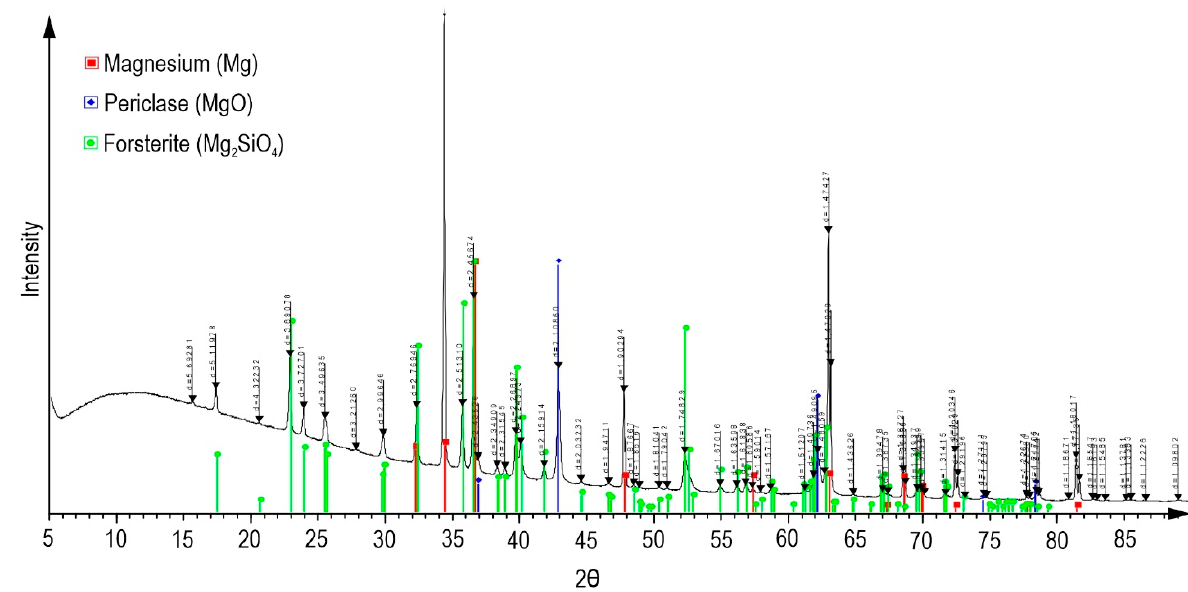
Figure 3. X-ray diffraction pattern of the sample with PEO coating.